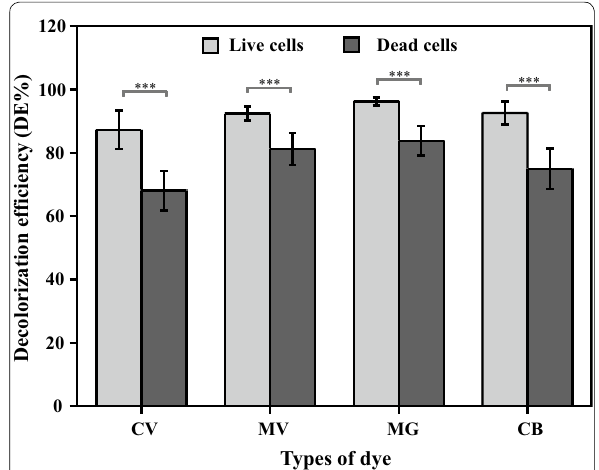
Fig. 3 Influence of live cells and dead cells on decolorization of CV, MV, MG and CB by SWUSI4 at 30 2 °C. “***” indicates significant ± difference based on paired T -test ( p < 0.01). Bars indicate